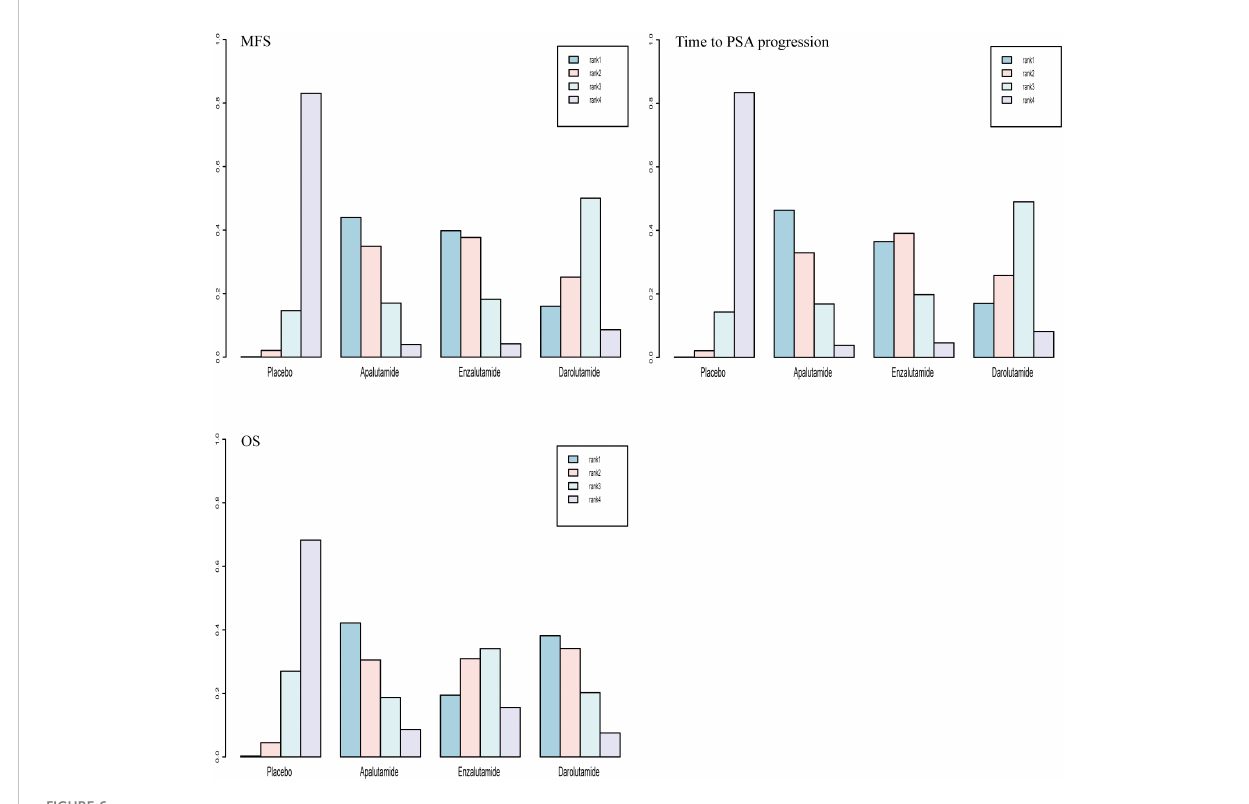
FIGURE 6 Rank probabilities of the SGARIs studied in the nmCRPC study.